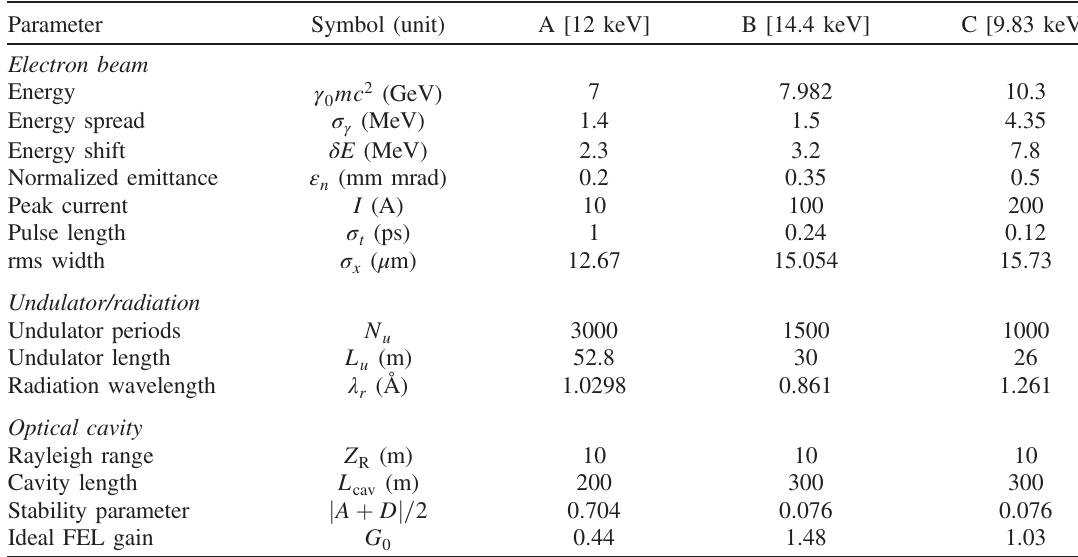
TABLE I. XFELO parameters for